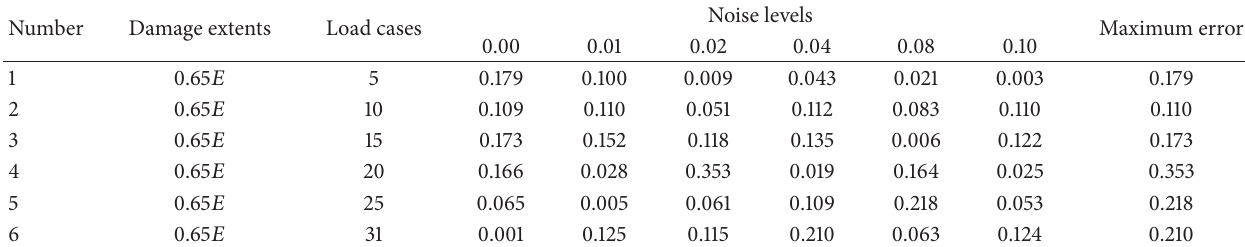
Table 21: The identification errors of forecasted cases based on multiscale damage parameters.